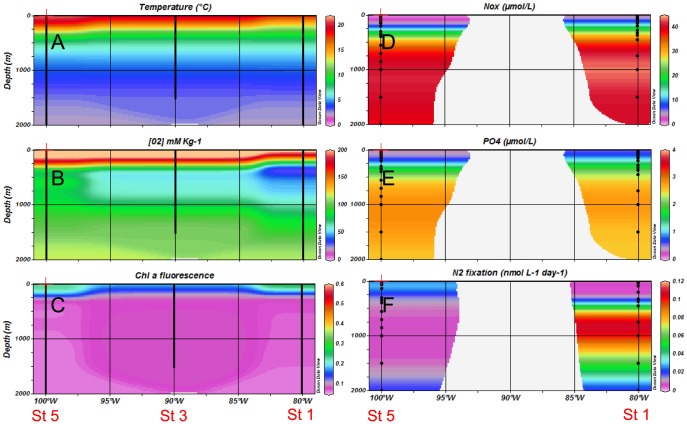
Horizontal and vertical distributions of hydrological and biogeochemical parameters during the 2011 cruise (R/V Melville) – Southern transect (20°S).(A) temperature, (B) dissolved oxygen, (C) chlorophyll a fluorescence, (D) NO3
− concentrations, (E) PO4
3− concentrations, (F) Mean N2 fixation rates (n = 3).